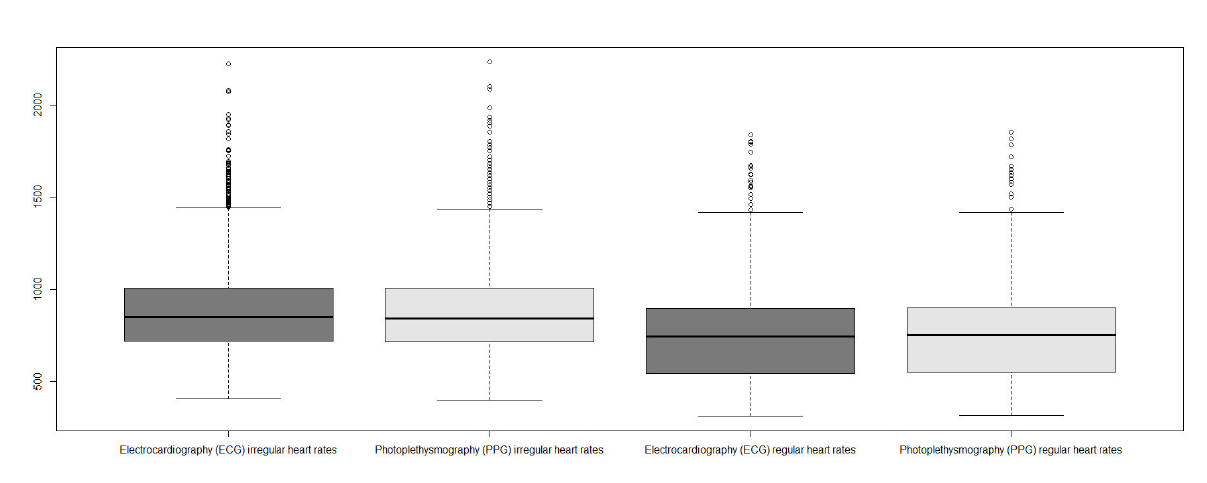
Figure 12. Overview of beat-to-beat intervals divided in irregular and regular